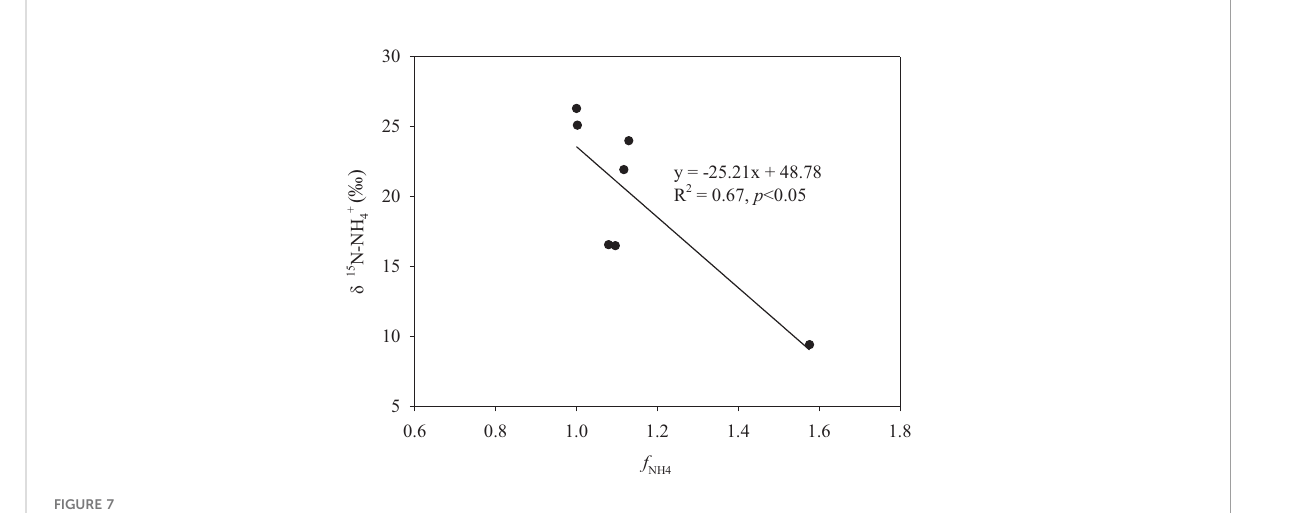
FIGURE 7 Linear relationship between d 15 N-NH 4+ and f NH4 in the upper